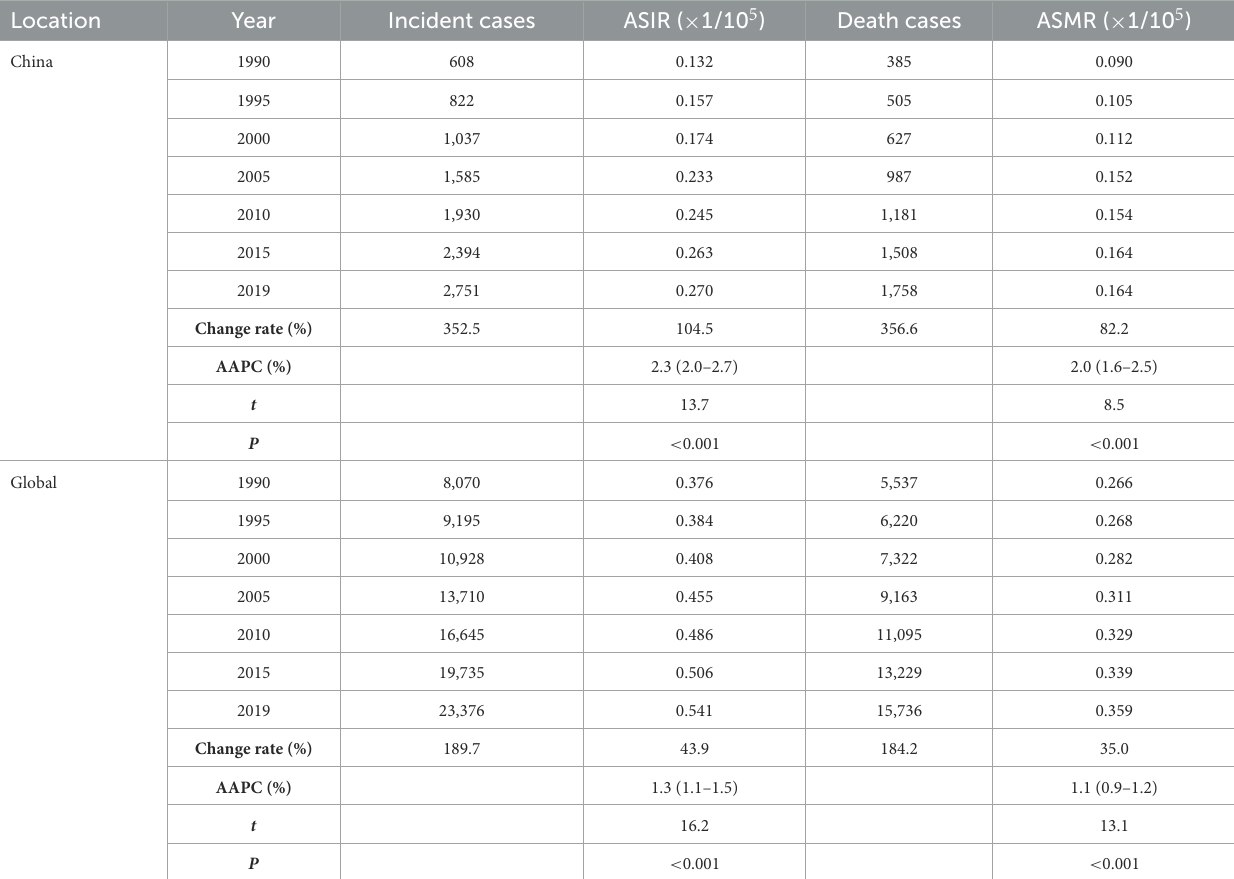
TABLE 1 Incidence and death of ovarian cancer attributable to hyperglycemia from 1990 to 2019. Location Year Incident cases ASIR ( × 1/10 5 ) Death cases ASMR ( × 1/10 5